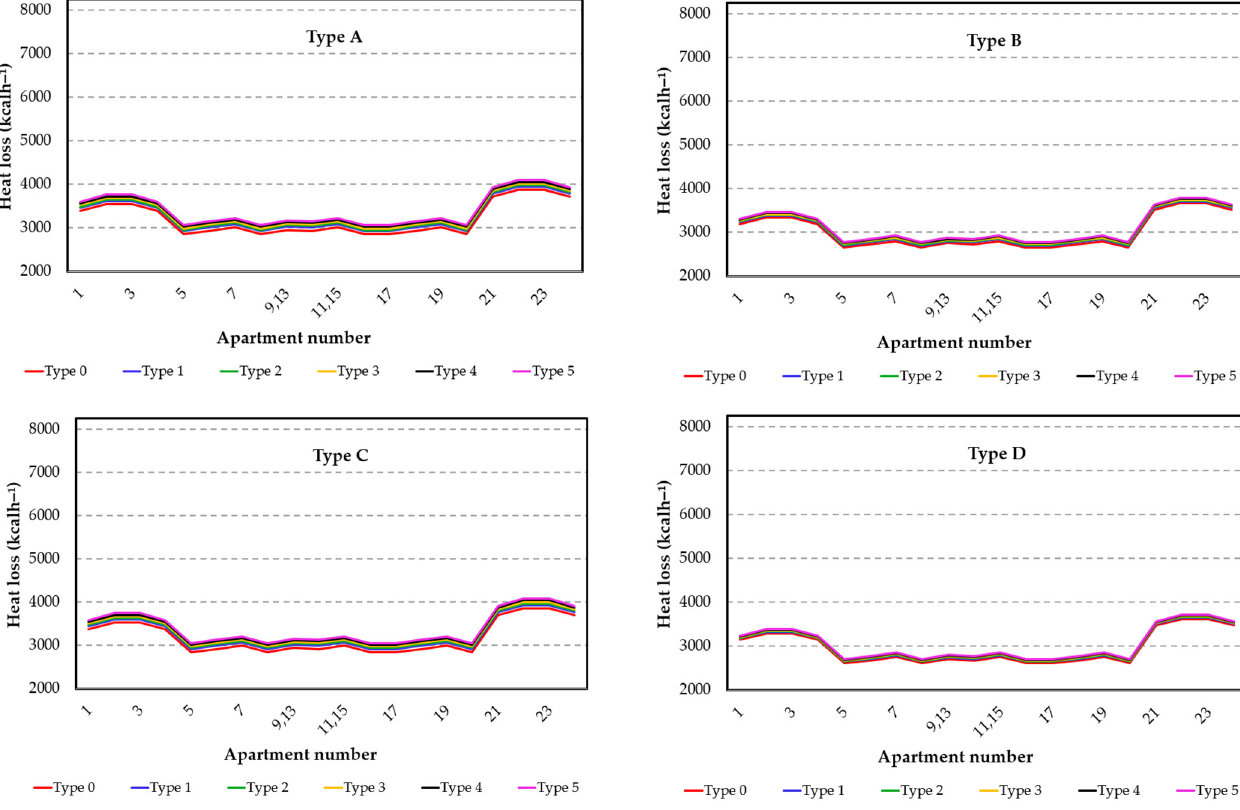
Figure 5. Comparison of heat loss according to window type for Antalya.